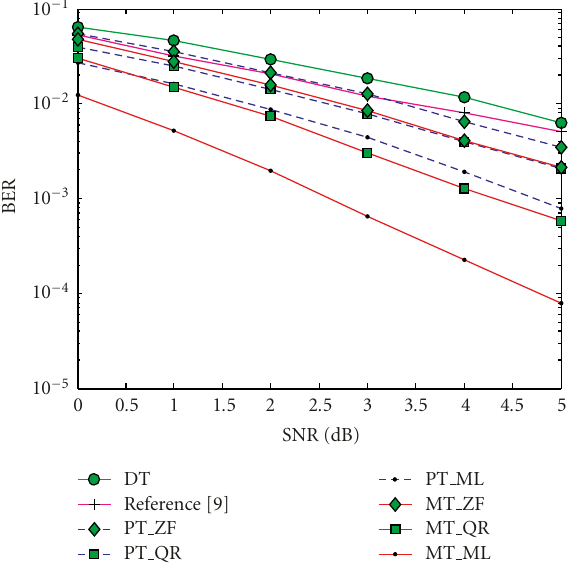
Figure 8: BER versus SNR (SNR in = SNR + 20 dB, SNR rd = SNR + 5dB).